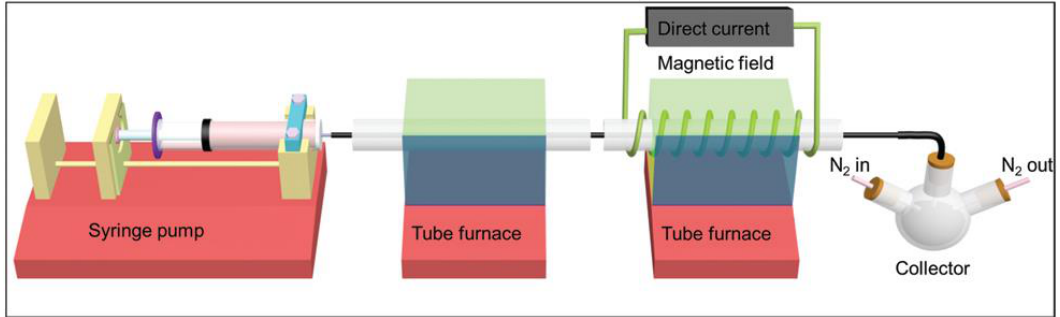
Figure 14. The four steps in the magnetic field-coupling microfluidic preparation process. Used with permission from [105]; permission conveyed through Copyright Clearance Center, Inc.